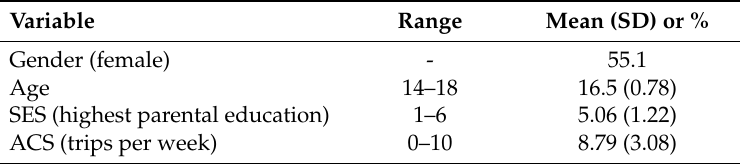
Table 1 indicates descriptive statistics for all participants. Table 1. Descriptive statistics of the sample (n =